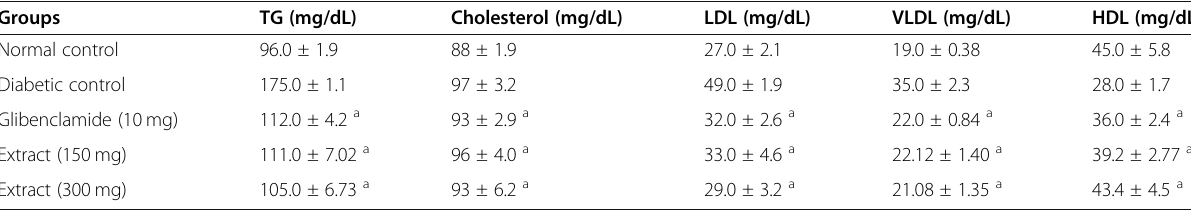
Table 6 Consequences of rhizomes of Sorghum halepense (L.) Pers extract on the concentration of serum ’ s LDL cholesterol, triglycerides, VLDL cholesterol, total cholesterol and HDL cholesterol